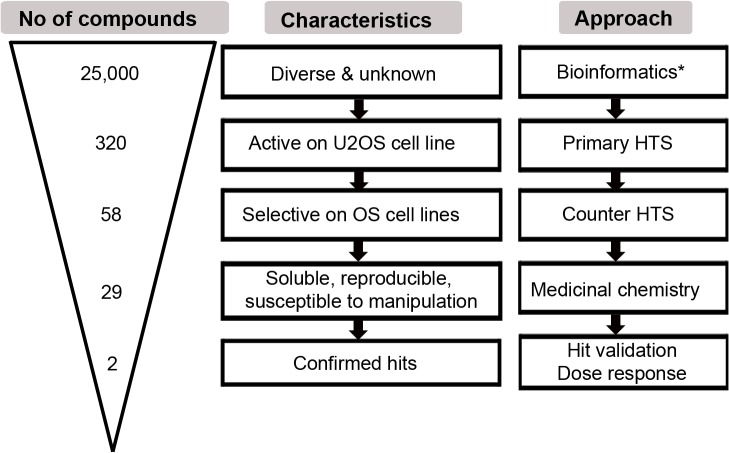
Workflow of the screening strategy.The graphic shows the number of compounds (triangle on the left), their characteristics (mid row) and the respective approach (right) that was applied for compound selection. Arrows from top to bottom indicate the “timeline“. *described in [19].